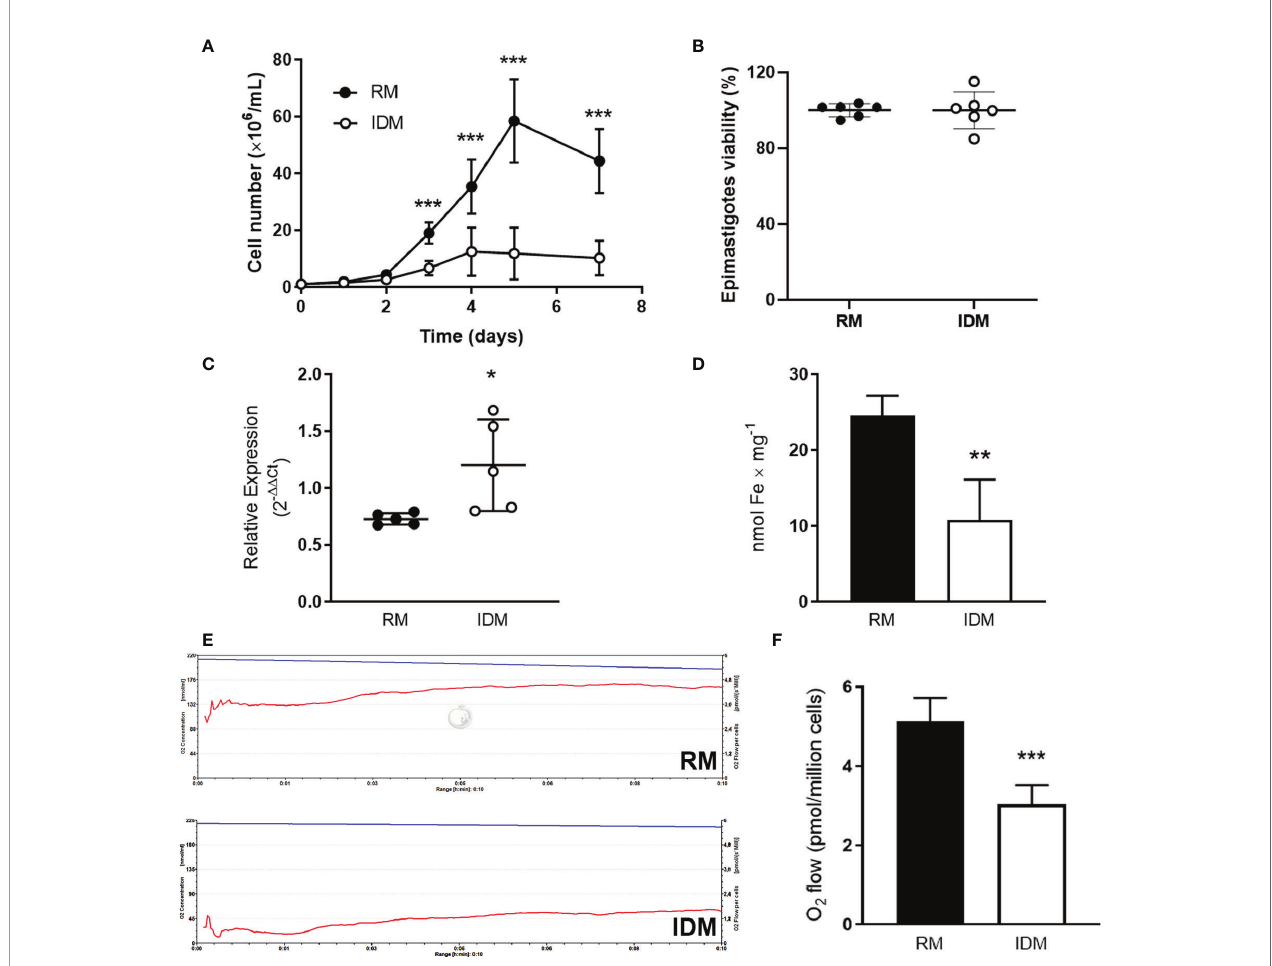
FIGURE 2 | Growth and respiration of wild-type epimastigotes are dependent on Fe content in culture medium and Fe depletion increases the expression of TcIT. (A) In fl uence of culture medium Fe content on T. cruzi proliferation. Wild-type epimastigotes of T. cruzi at mid-log phase were harvested, washed twice, seeded in fresh medium, and grown for the indicated times in regular medium [RM: brain heart infusion medium (BHI) supplemented with 30 µM hemin and 10% fetal bovine serum (FBS)] ( fi lled circles) or in iron-depleted medium (IDM: BHI without hemin supplementation and treated with Chelex for ionic Fe depletion plus 10% iron- depleted FBS) (empty circles); *** P < 0.001 ( n = 12). (B) Viability of epimastigotes incubated in RM ( fi lled circles) or IDM (empty circles) (5 × 10 7 epimastigotes/ml) was assayed using the MTT assay. (C) Quanti fi cation of the TcIT transcript in wild-type T. cruzi epimastigotes. Quantitative PCR was done using 100 ng cDNA from epimastigotes in mid-log phase when maintained in RM ( fi lled circles) or IDM (empty circles); * P < 0.05 ( n = 5). The housekeeping GADPH gene was used to normalize qPCR. (D) Intracellular Fe content in epimastigotes maintained in RM (black bars) or IDM (empty bars); ** P < 0.01 ( n = 6). (E) Representative recordings of O 2 consumption rates vs. time (pmol/s per cell; lower traces in both panels) and decrease of O 2 concentration (nmol/ml; upper traces in both panels): 5 × 10 7 epimastigotes/chamber from RM (upper panel) or IDM (lower panel) were harvested, washed twice, and used to measure O 2 consumption in reaction medium (2 ml) containing 116 mM NaCl, 5.4 mM KCl, 5.5 mM D-glucose, 50 mM HEPES – Tris (pH 7.2). (F) Quanti fi cation of O 2 consumption by epimastigotes incubated in RM (black bars) or IDM (empty bars) (*** P < 0.001; n = 6). In all cases, using unpaired Student ’ s t -test assessed differences between mean values. In (A) , the differences were assessed by comparing time-matched